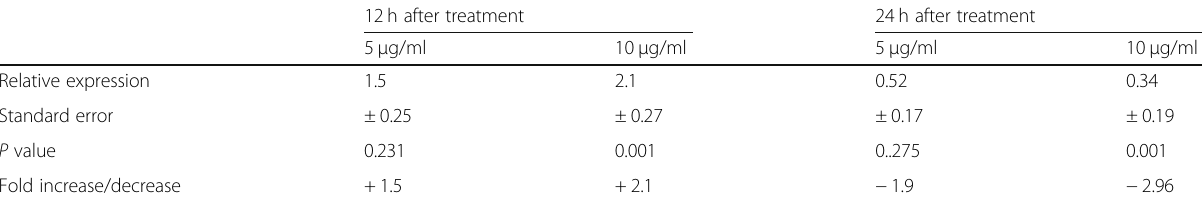
Table 6 The total expression ratio of the gene of bFGF in the MEFs treated with various concentration of methanol extract of Calendula (5 and 10 μ g/ml) relative to control group is presented in each time (12 and 24 h after treatment). The statistic test for significance is randomization re-allocation test, implemented in the relative expression software tool. Significant down or upregulations of the genes highlighted 12 h after